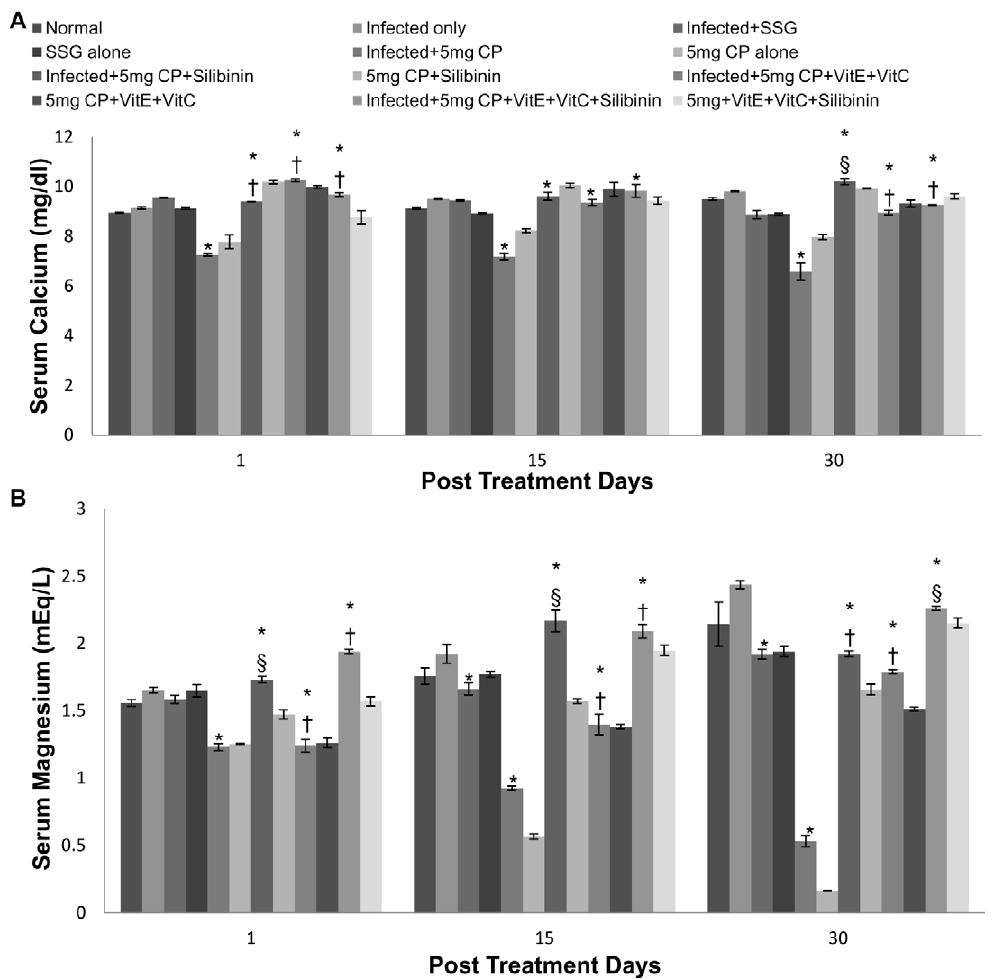
Figure 10. Calcium and magnesium levels in serum samples of different groups of animals. A- Calcium, B- Magnesium. The data are presented as mean 6 S.D. of six mice per group. * -p value: Infected only vs Infected + SSG/Infected + 5 mg CP/Infected + 5 mg CP + Silibinin/ Infected + 5 mg CP + VitE + VitC/Infected + 5 mg CP + VitE + VitC + Silibinin. { , 1 -p value: Infected + 5 mg CP vs. Infected + 5 mg CP + Silibinin/Infected + 5 mg CP + VitE + VitC/Infected + 5 mg CP + VitE + VitC + Silibinin. *, { -p , 0.001; 1 -p ,